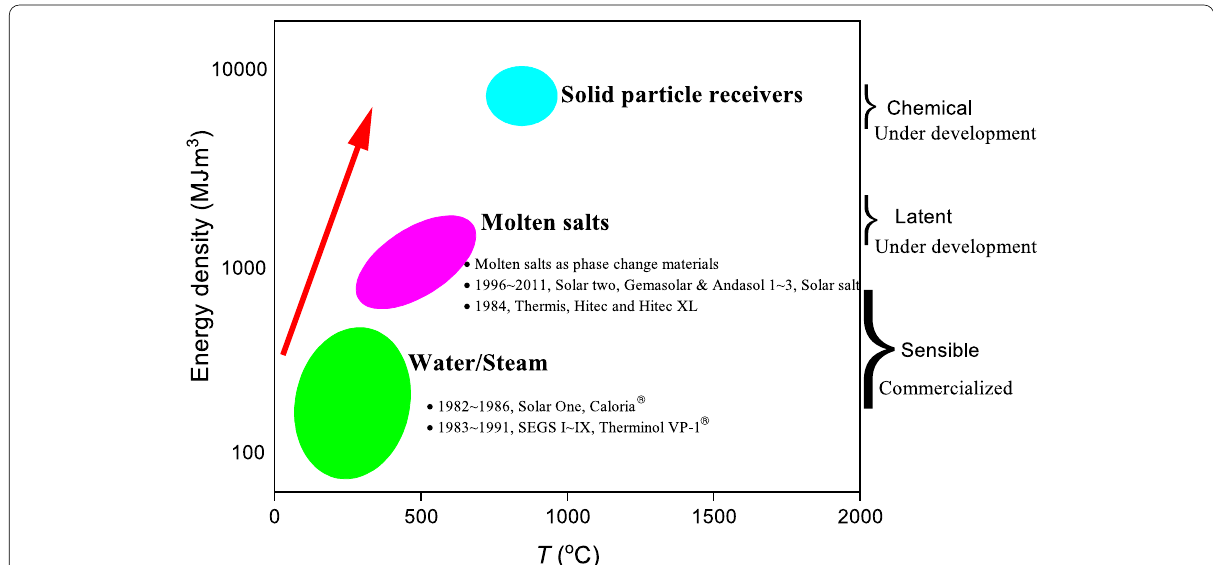
Fig. 23 Evolution of technological concepts of thermal energy storage materials for CSP. The new generation of technologies towards to higher temperature enables higher efficiencies